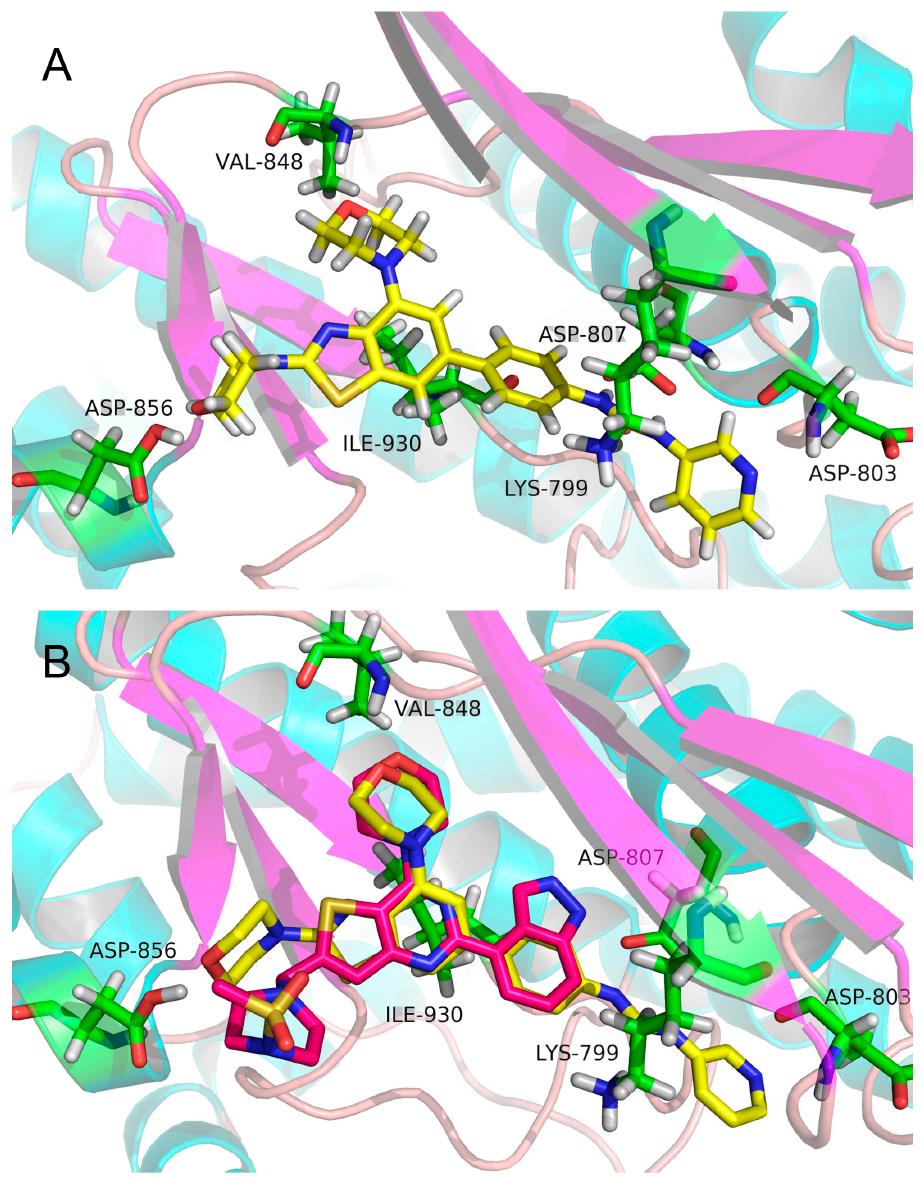
Figure 3. ( A ): schematic of the binding mode of compound 11 with PI3K β kinase; ( B ): the contrast of binding mode between compound 11 (yellow) and GDC-0941 (red).